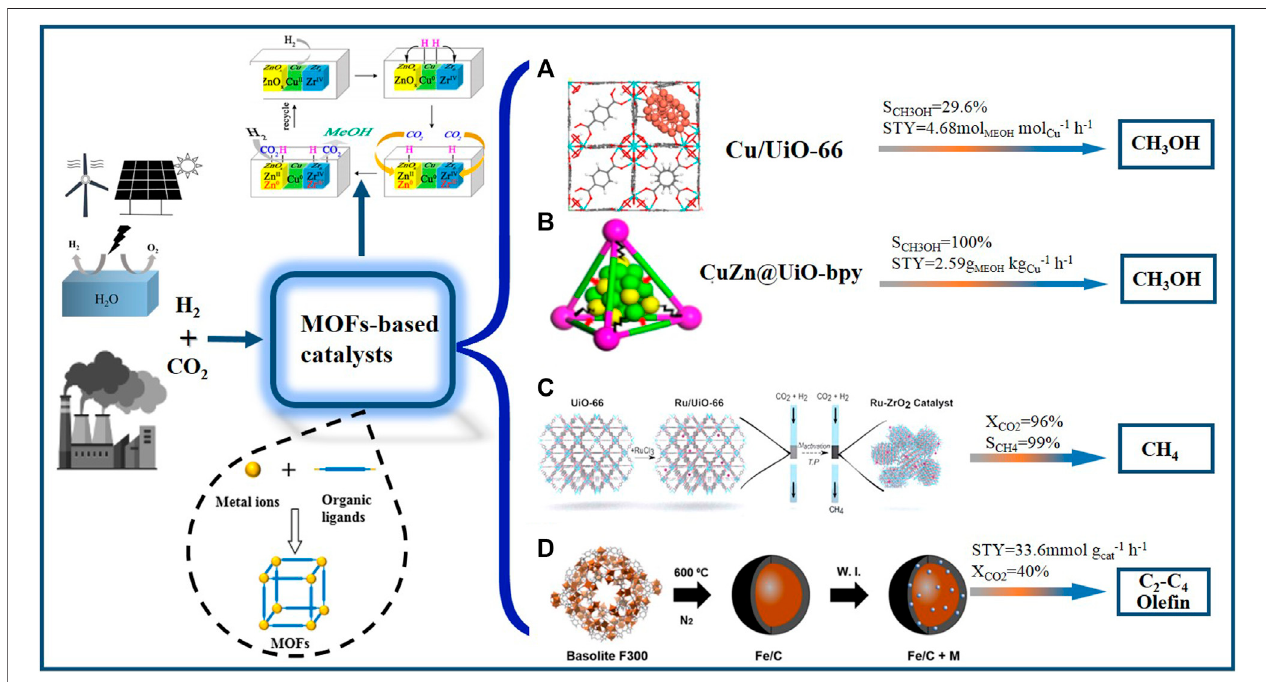
FIGURE1| CO 2 hydrogenationovervariousMOFs-based catalysts. (A) Interfacebondingofsub-nanometerCuclusterswithZr 6 O 8 nodesoverCu/UiO-66andits catalytic results in CO 2 hydrogenation to methanol. Reproduced with permission from Zhu et al. (2020). Copyright 2020 Springer Nature. (B) The Cu/ZnO x NPs embedded UiO-bpy and its catalytic results in CO 2 hydrogenation to methanol. Reproduced with permission from An et al. (2017). Copyright 2017 American Chemical Society. (C) Structuralevolution in the decomposition process ofRu/UiO-66 and its catalytic results obtained material for CO 2 hydrogenation to CH 4 . Reproduced withpermissionfrom Lippiet al.(2017).Copyright2017RoyalSociety ofChemistry. (D) Fe/C-KcatalystfabricatedthroughdecompositionofBasoliteF300MOF andits catalytic results obtained material for CO 2 hydrogenation to CH 4 . Reproduced with permission from Ramirez et al. (2018). Copyright 2018 American Chemical Society.